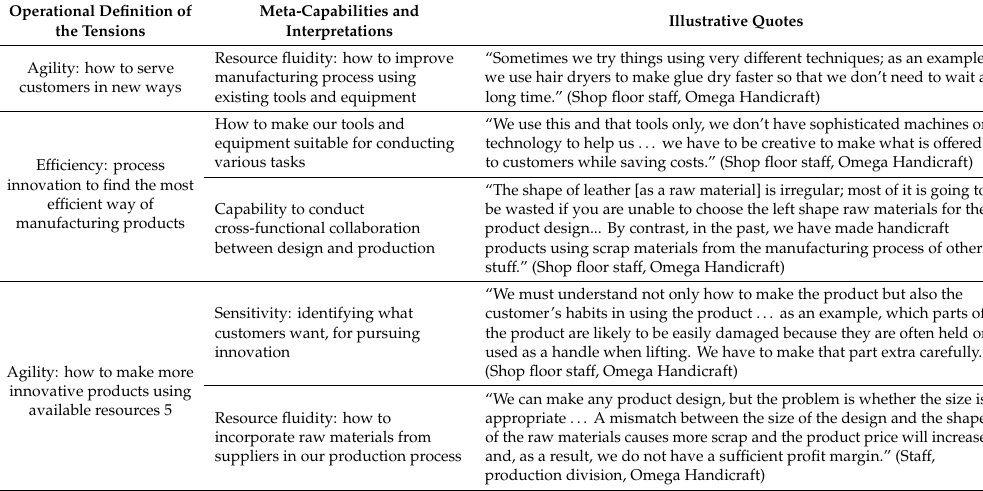
Table 6. Introducing new products or improving